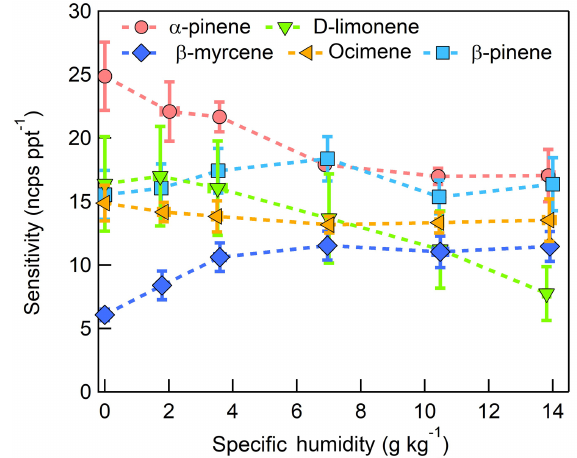
Figure 11. Humidity-dependent, CI-ToFMS monoterpene sensitiv- ities reported as the sum of all detected masses (135, 136, and 168 m/Q ). Error bars represent the standard deviation of the trip- licate calibrations. All calibrations were performed in zero